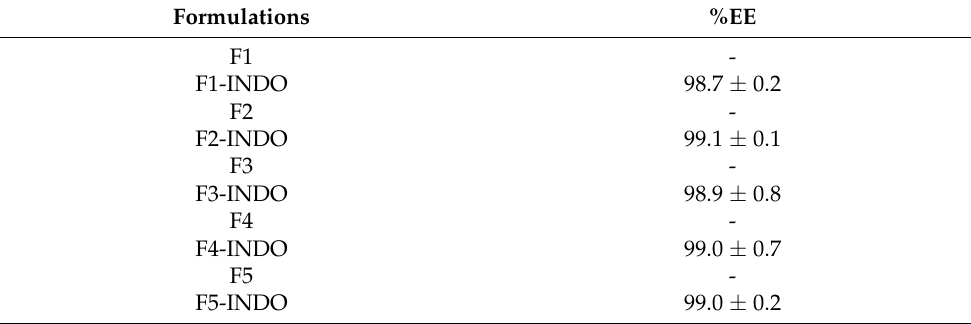
Table 3. Encapsulation efficiency from different NLC formulations loading indomethacin (2%), n =